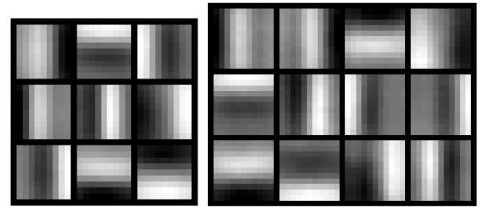
Figure. 5 Learned encoders of autoencoders. Left: setting 1) ; Right: setting